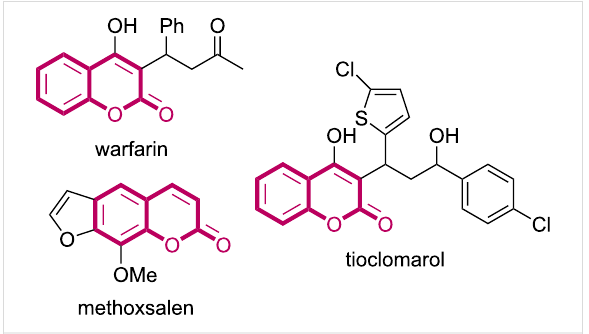
Figure 1: Coumarin-derived commercially available